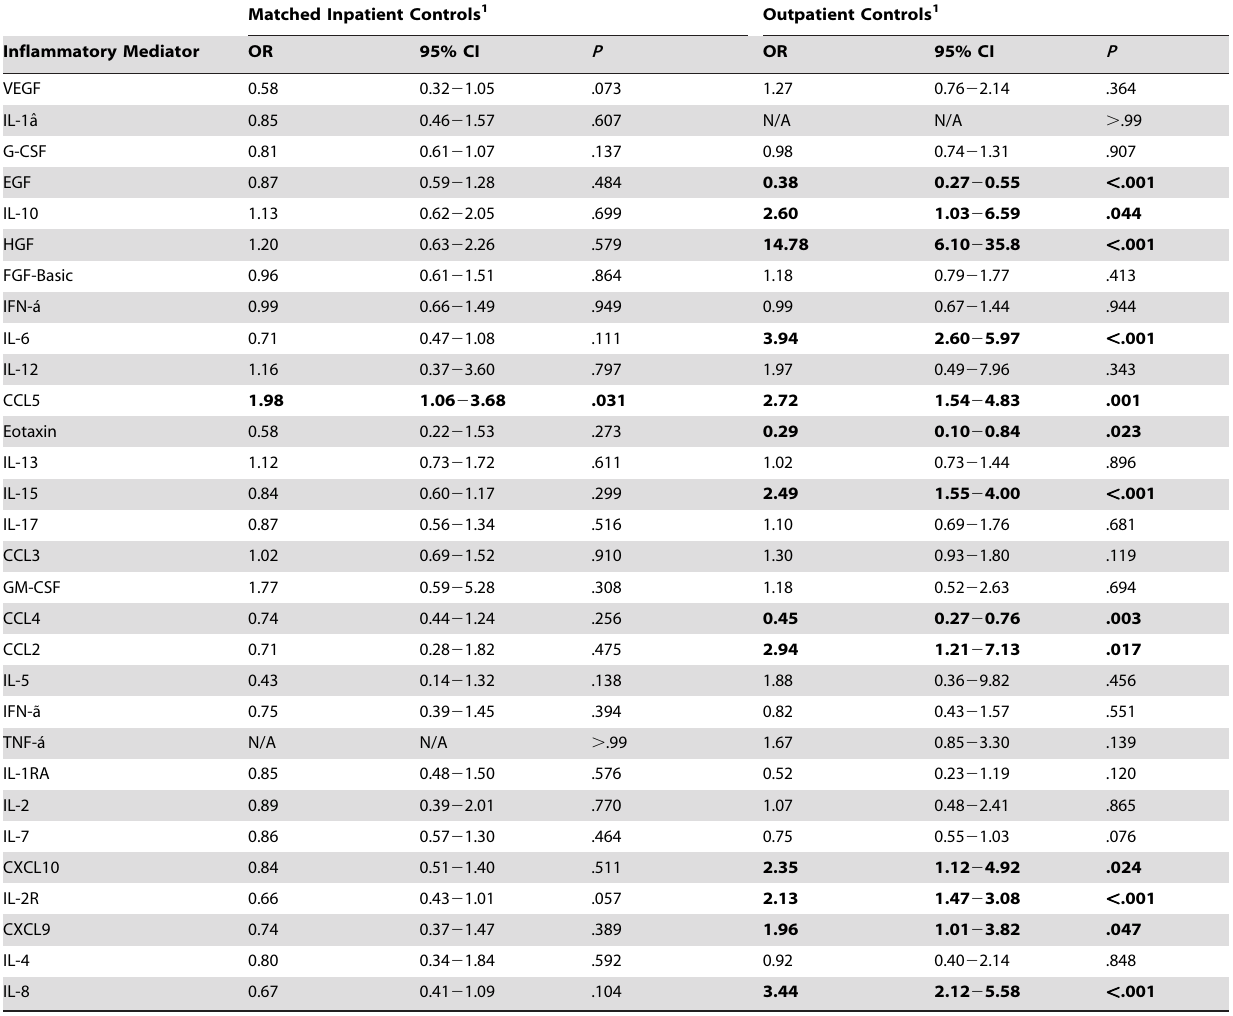
Table 3. Simple logistic regression results for serum inflammatory mediators (cytokines, chemokines, and growth factors) in patients with Clostridium difficile infection (CDI) vs. matched inpatient controls who tested negative for CDI and asymptomatic outpatient controls (all units in log - 10